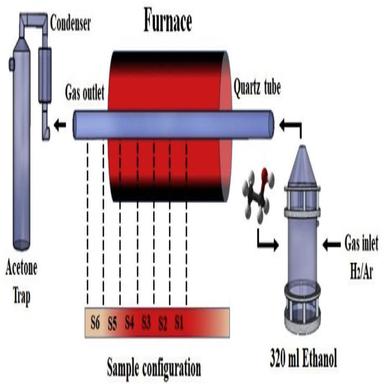
Schematic representation of the vapor-catalytic chemical vapor deposition system (VC-CVD). A six Cu-foils were located alongside the quartz tube (reactor), which were labeled by S1, S2, S3, S4, S5, and S6. The ethanol vapor was transported by a gas composed by H2/Ar (5%/95% wt/wt). The furnace temperature was kept at 960 C and the temperature profile alongside the furnace can be seen in figure SI-1. (A colour version of this figure can be viewed online.)